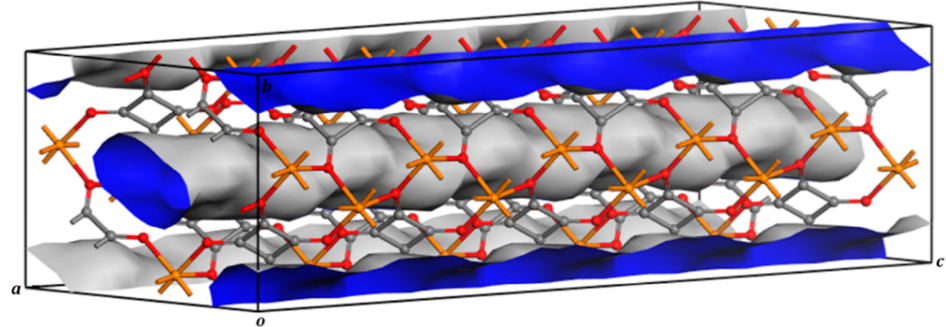
Figure 1. Computed crystal structure of copper squarate: view of a 2 × 2 × 2 supercell from [0 0 1] direction. Color code: Cu—orange; C—gray; O—red.